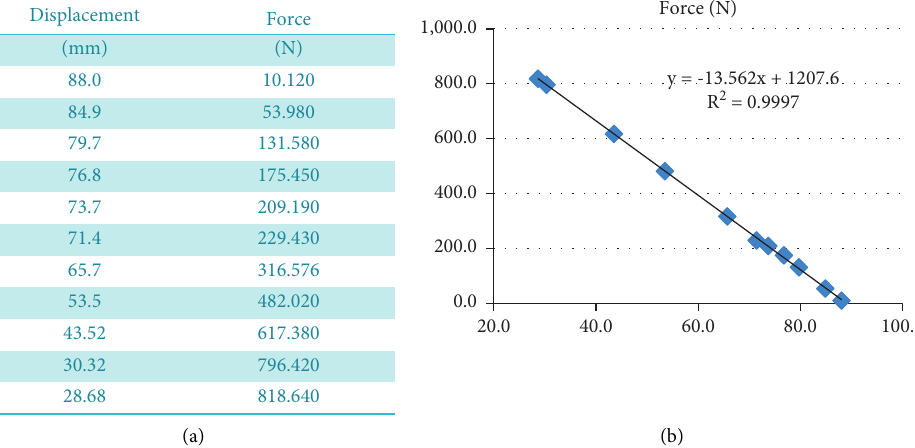
Figure 9: (a) Displacement and force of spring; (b) stiffness calculation.